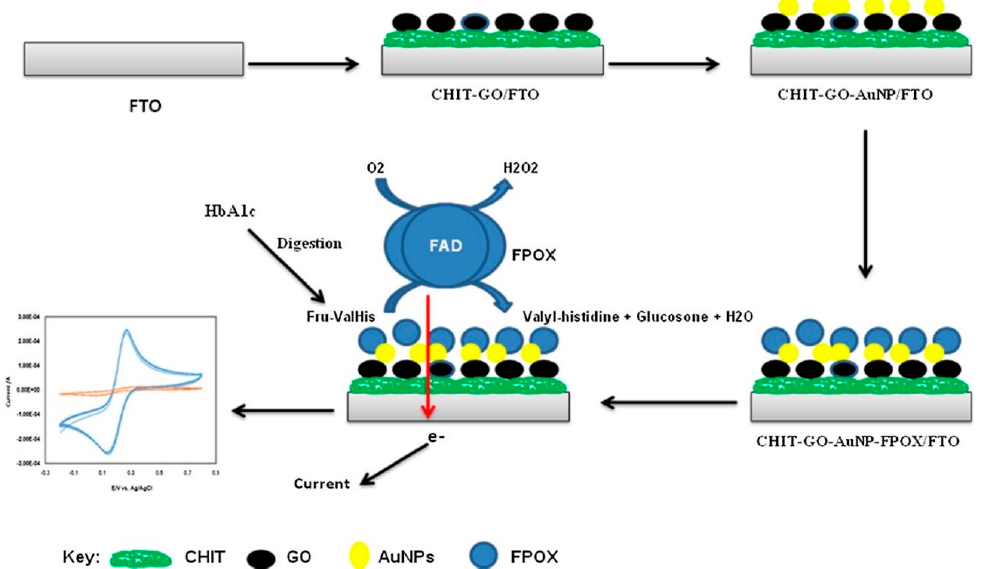
Figure 8. Modified working electrode FPOX/CHIT-GO-AuNPs/FTO for amperometric detection of FV. Reprinted with permission from